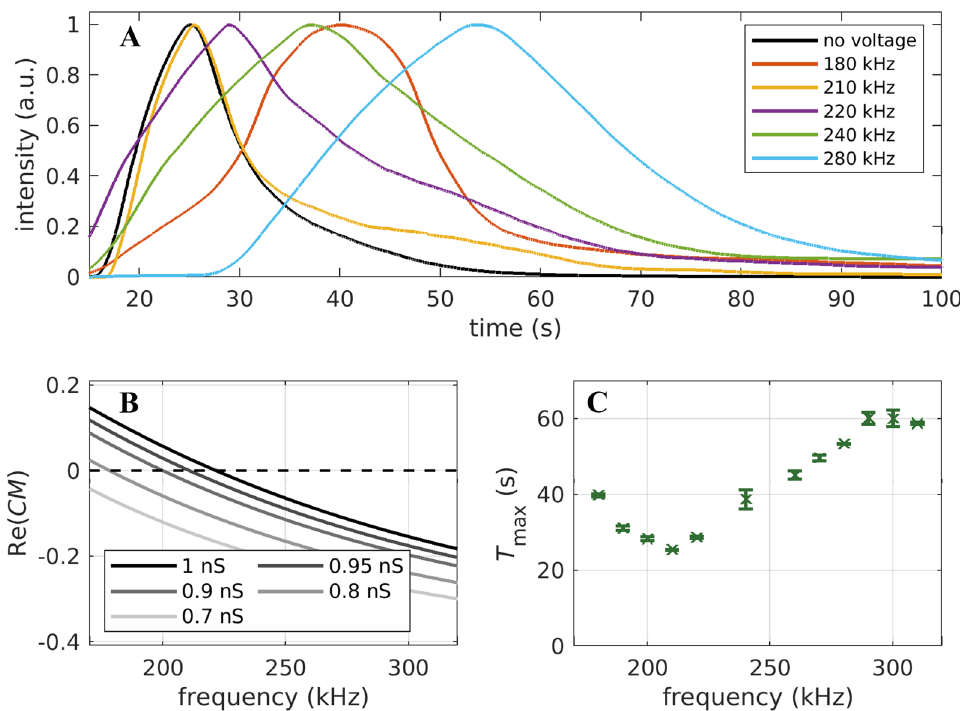
Figure 2. ( A ) Residence time distributions at 120 V pp for different applied frequencies in fixed-frequency dielectrophoretic particle chromatography. ( B ) Calculated values of the real part of the Clausius–Mossotti equation for different surface conductances ( d p = 3.1 µ m PS particles without surface functionalization in a 2 µ S cm − 1 suspension). The dashed line represents Re ( CM ) = 0 . ( C ) Maximum of the residence time